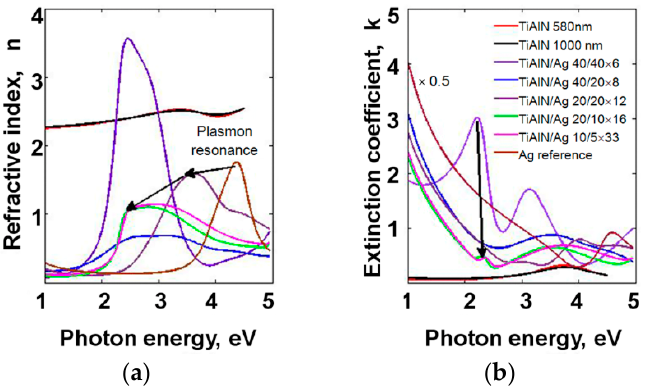
Figure 6. Refractive index n ( a ) and extinction coefficient k ( b ) of deposited TiAlN/Ag coatings and Ag reference calculated using the Transfer Matrix Method (TMM).